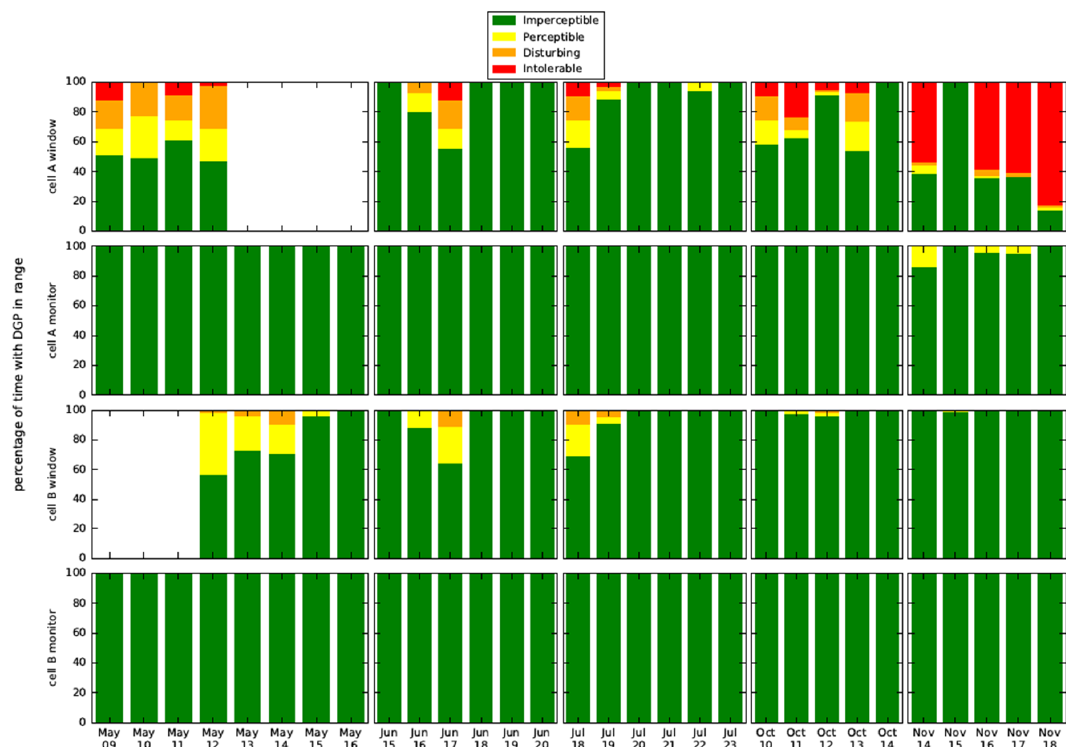
Figure 4. The daily fraction of time spent in each daylight glare probability (DGP) class (imperceptible ( < 0.35), perceptible (0.35–0.39), disturbing (0.40–0.45), and intolerable ( > 0.45)) is illustrated, with days lacking data shown in white. Day-to-day comparisons of the baseline cell (A) and retrofit cell (B), particularly for the view location facing the window, show improved glare performance for the retrofit cell. DGP classes are further described in Footnote 2.